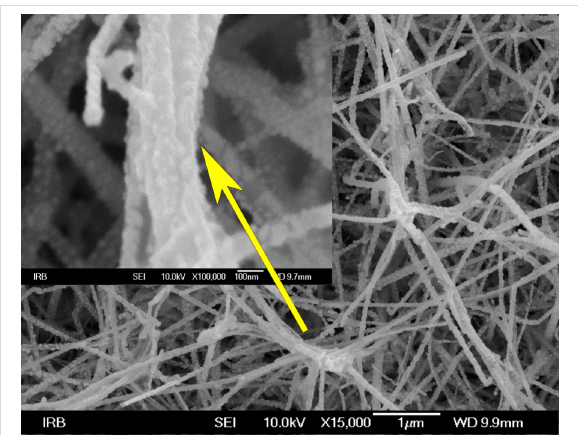
Figure 5: SEM images of SiNWs obtained through VLS deposition at 500 °C, then sputtered Ag for 3 min and finally immersed in H 2 O.